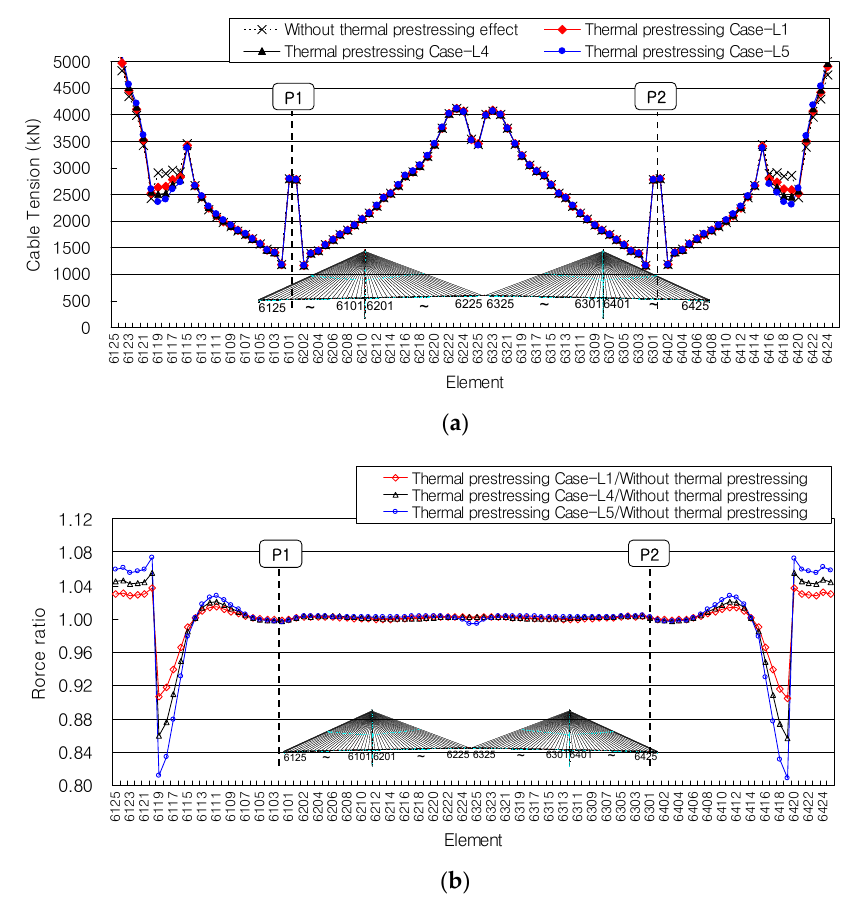
Figure 14. Cable forces for various elongation lengths. ( a ) Cable forces after completed construction; ( b ) Cable force ratio.